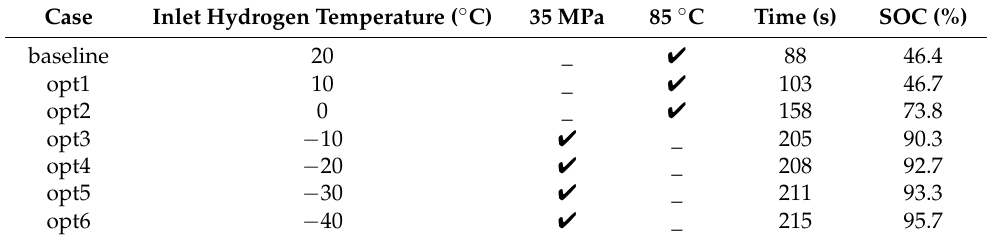
Table 3. State of charge of cylinders.